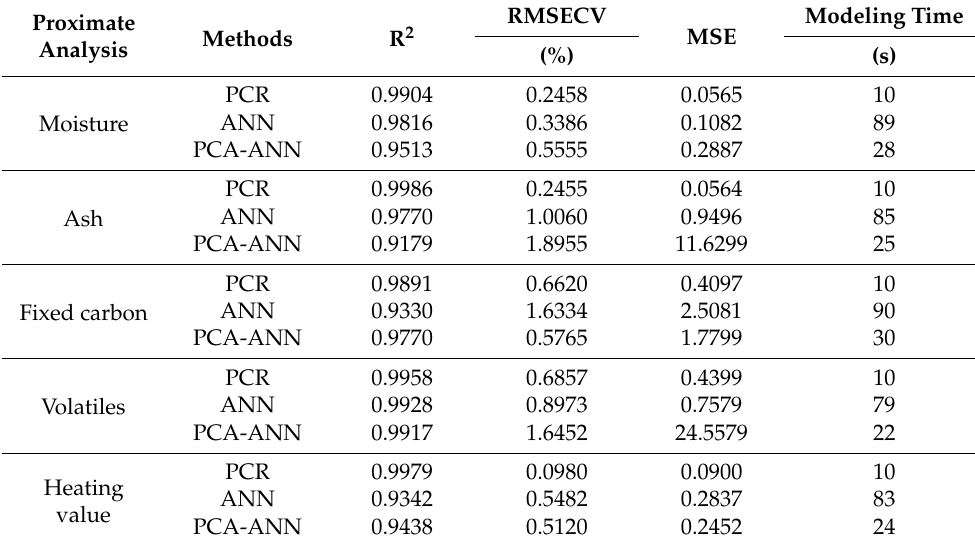
Table 3. Quantitative analysis of the three chemometric methods.